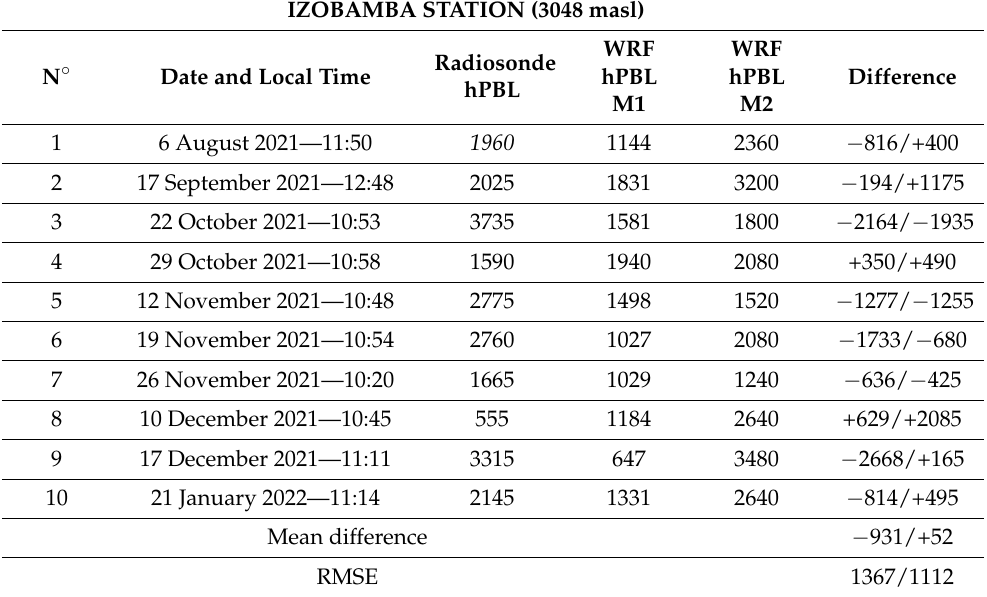
Table 6. Comparison of hPBL values at the IZ station between Radiosonde and